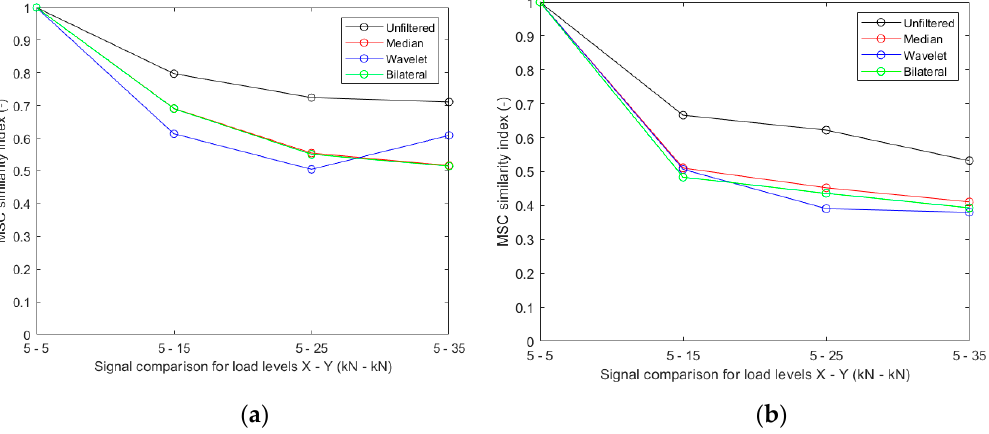
Figure 11. Magnitude-squared coherence (MSC) values for different denoising approaches: ( a ) results for Accelerometer 1; ( b ) results for Accelerometer 2.